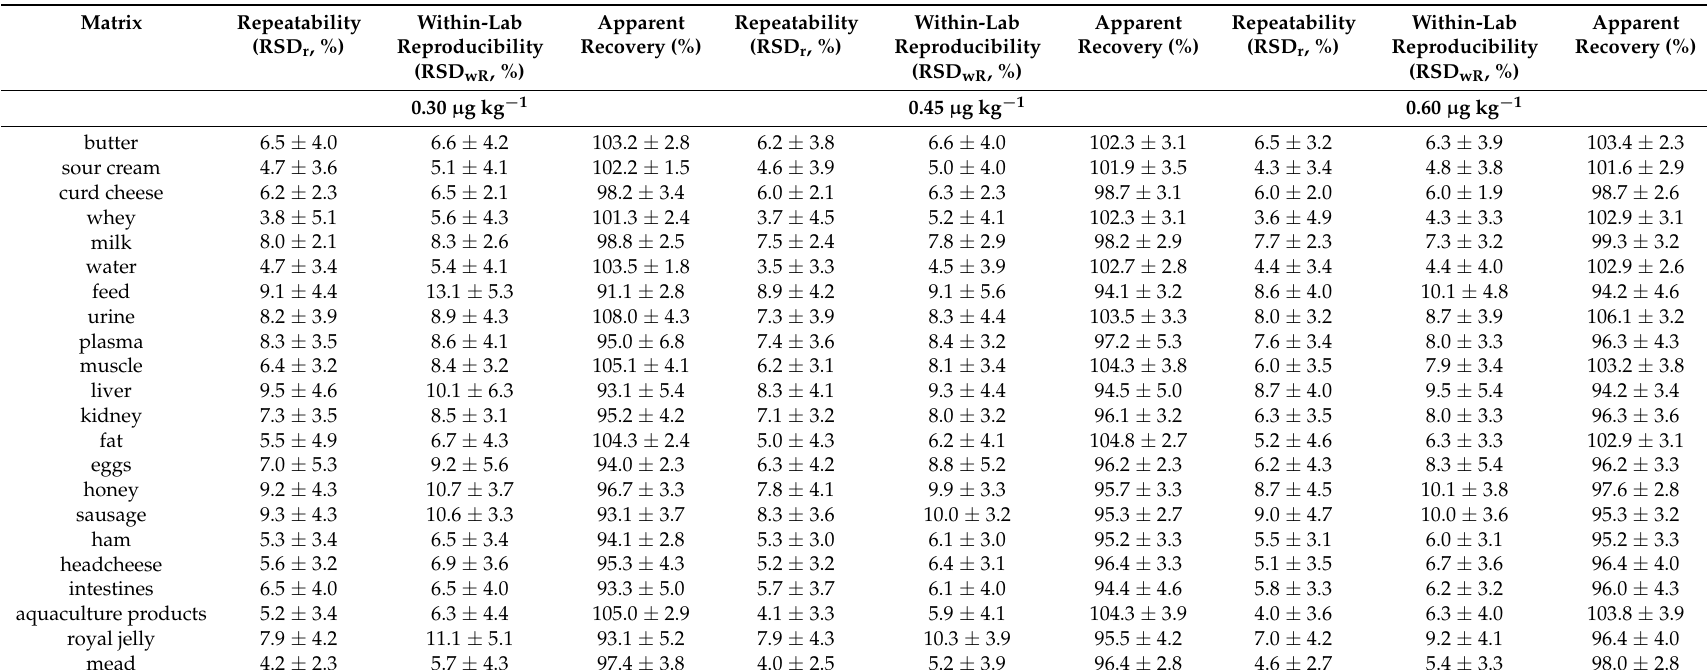
Table 2. Parameters obtained for the calibration